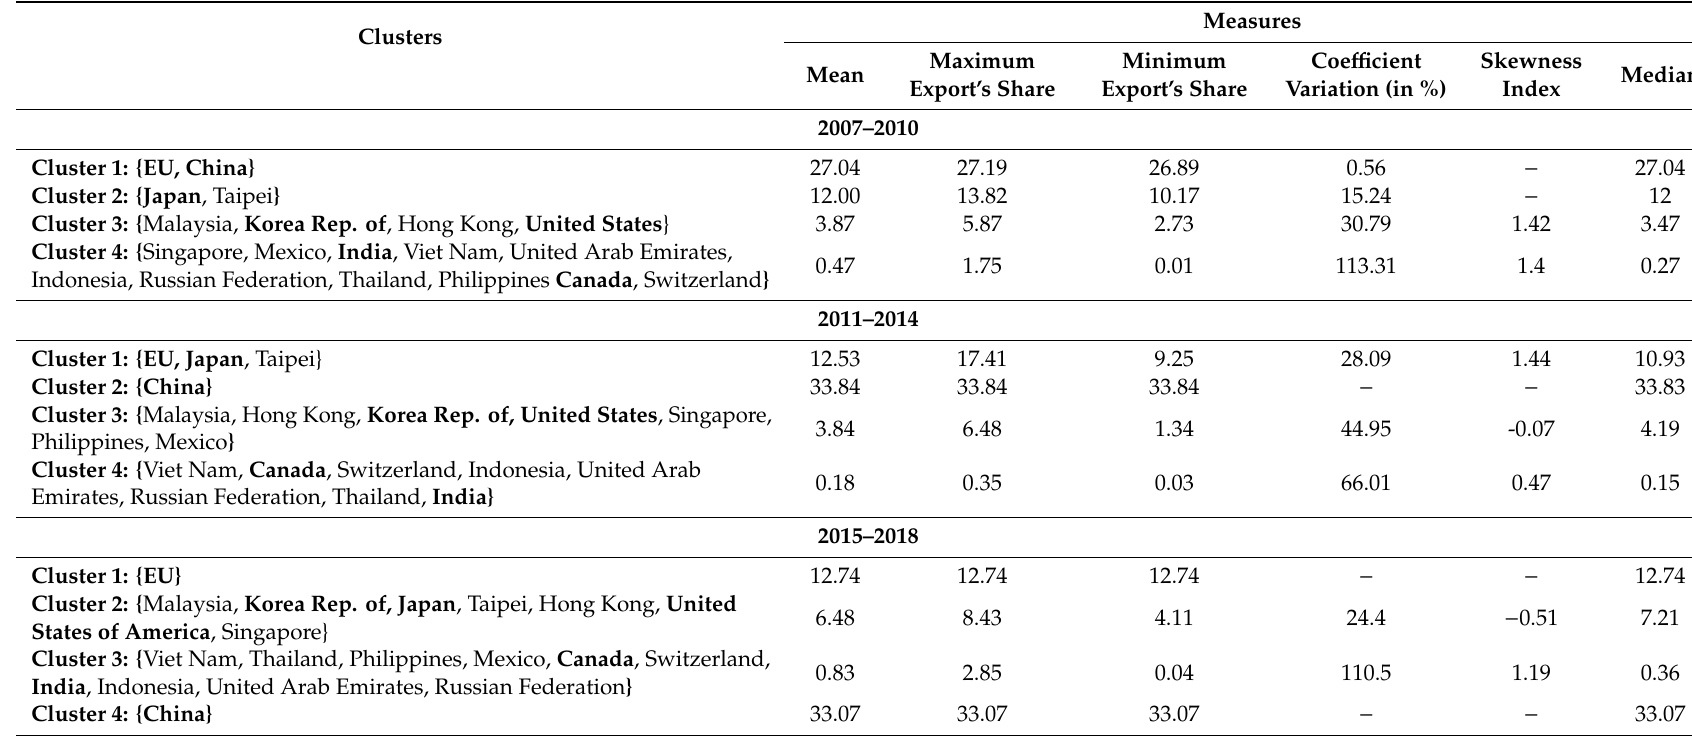
Table 3. The share of country’s exports in world exports of photovoltaic panels for the top 19 countries, in 2007–2018. Clusters